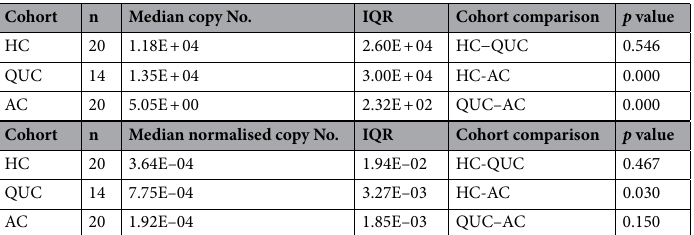
Table 5. Median copy number/mg and median relative abundance of B. wadsworthia after normalisation for total bacterial copy number in each patient cohort.